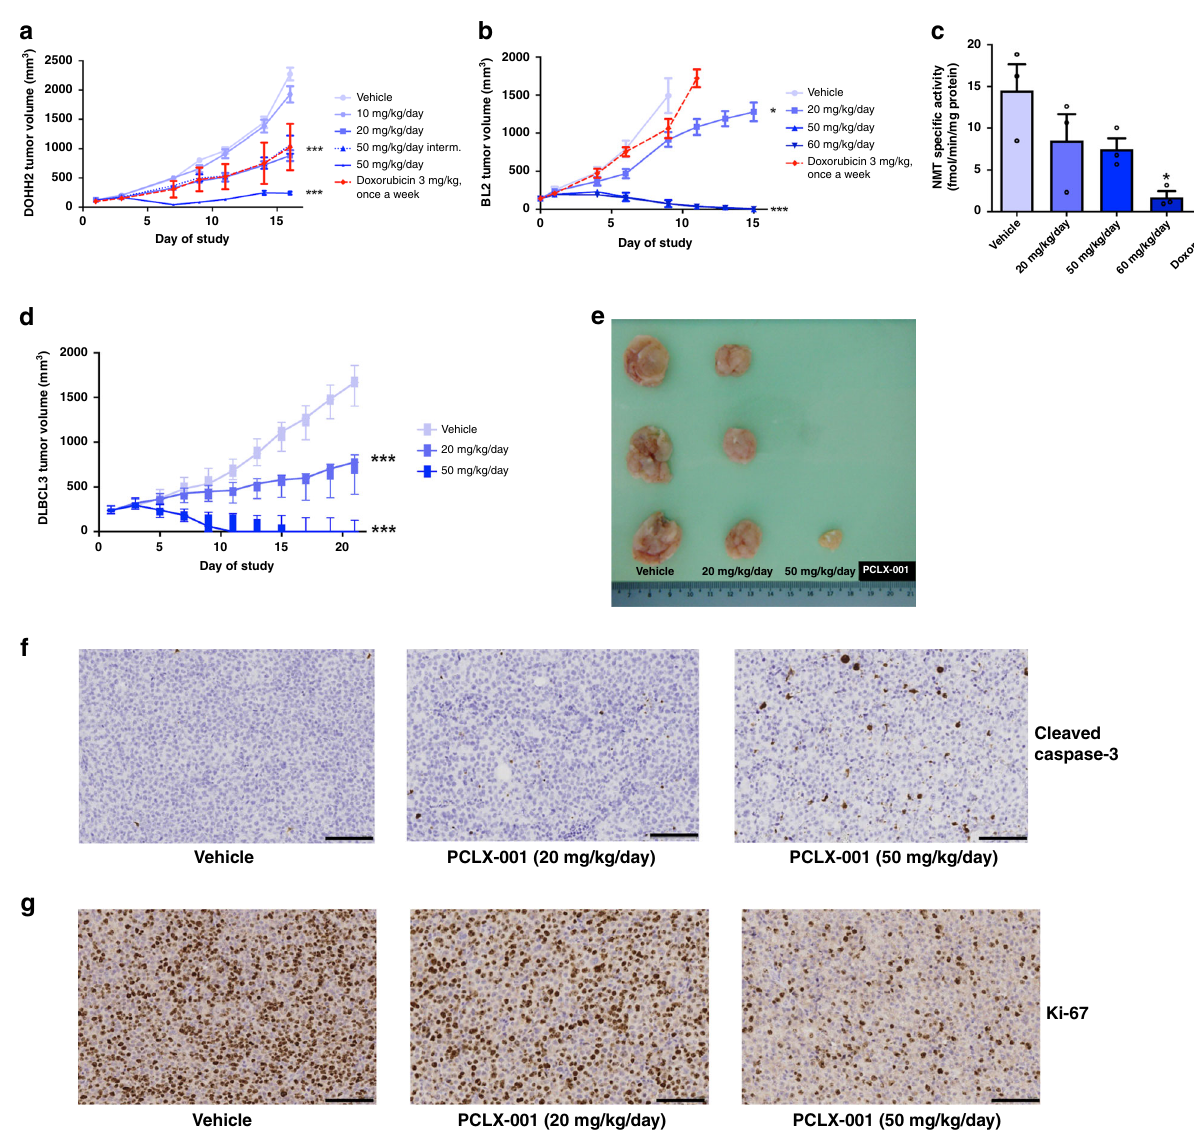
Fig. 7 PCLX-001 treatment reduces tumor volumes and leads to complete tumor regression in B-cell lymphoma xenograft models. Dose – response curves for murine subcutaneous xenografts derived from cell lines measuring the size of DOHH2 ( a ) and BL2 ( b ) tumors as a function of time. Error bars represent the standard deviation of average tumor volumes ( n = 10 per group). Average total NMT speci fi c activity assessed as previously described 21 in BL2 tumor samples from mice treated with PCLX-001, doxorubicin, or vehicle alone at the indicated doses. Tumor extracted from mice treated with 60 mg/kg/day have reduced NMT speci fi c activity as compared to vehicle (paired t -test, P = 0.0425). Error bars represent s.e.m. ( c ). Dose – response curve for the murine xenograft derived from patient DLBCL3. Datapoints represent average tumor volumes in all surviving animals. Error bars represent the standard deviation in the average tumor volumes ( d ). ***Indicates a signi fi cant difference in response rate between animals which received 20 mg/kg/day and 50 mg/kg/day of PCLX-001 ( P < 0.0001, n = 8 per group). Representative tumors from mice with patient-derived DLBCL3 xenografts ( e ). Representative IHC staining for cleaved caspase-3 ( f ) and Ki-67 ( g ) in the above DLBCL3 patient xenograft tumor samples. Scale bars equal to 100 μ m. Source data are provided as a Source Data fi